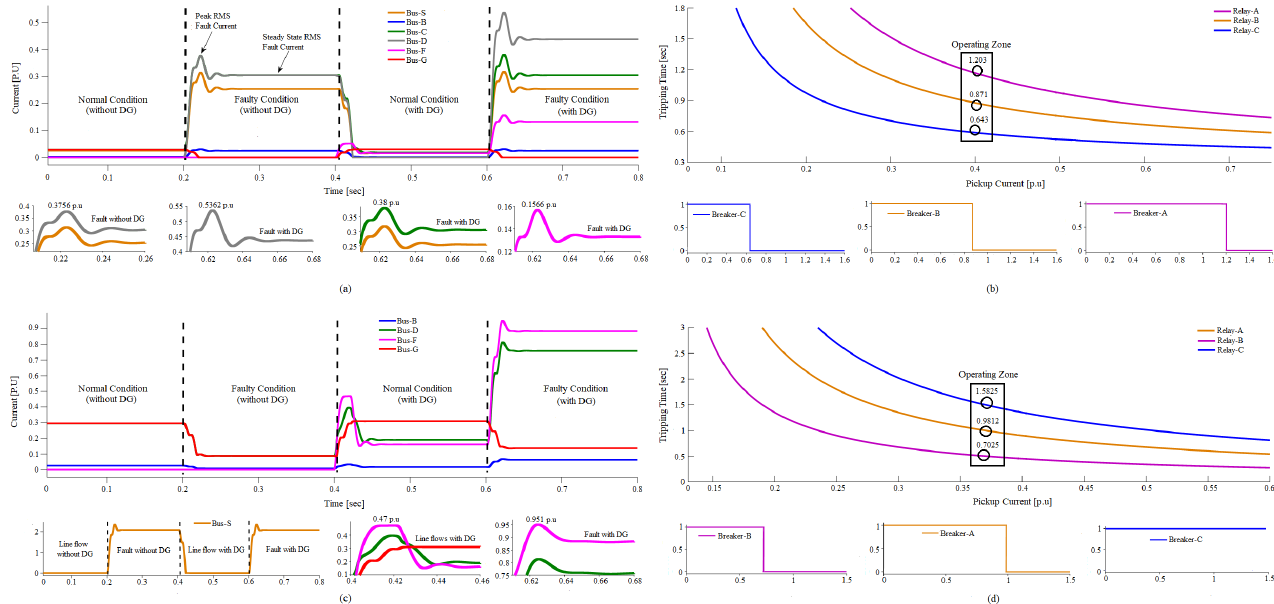
Figure 8. Current profile of the system for distinct network conditions and the coordination status of relay-breaker pair for upstream and downstream faults, ( a , c ) line flows under normal and fault conditions (for three phase and single phase to ground faults respectively) with and without DG being integrated, ( b , d ) inverse-time characteristics and tripping sequence of installed relay-breaker system for protection coordination against three phase and single phase to ground faults,